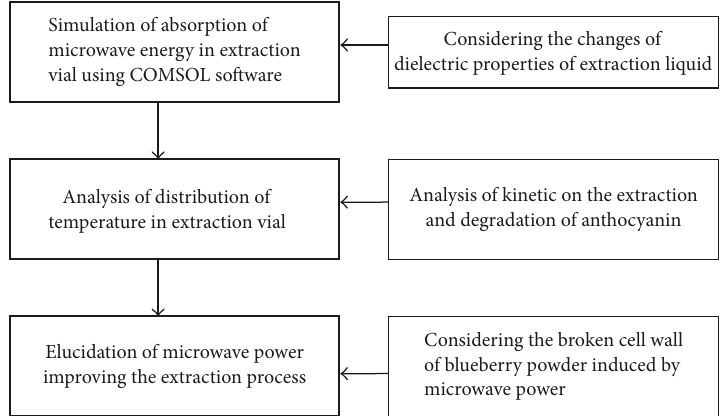
Figure 1: Research route for investigation of microwave powers on extraction and degradation of anthocyanin from blueberry powder considering absorption of microwave